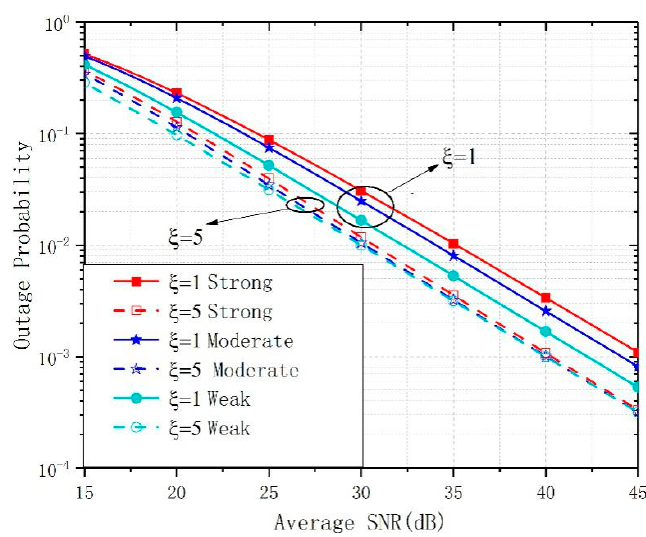
Figure 2. Outage probability against average signal-to-noise ratio (SNR) per hop for various turbulence intensities and di ff erent pointing error parameters. The constant is assumed to be C = 1, and the threshold of the hybrid system is γ th = 10 dB.